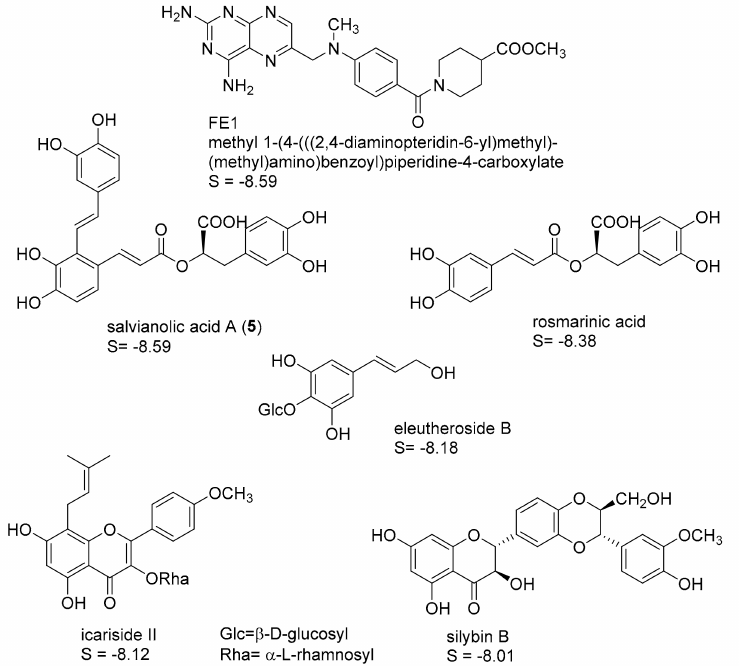
Figure 3. Best five hits from the virtual screening based on the FE1 pharmacophore ( Lm PTR1 PDB-ID “2QHX”); S-scores of the induced-fit docking simulations are given in kcal/mol. A “self-docking” computation of the co-crystallized inhibitor FE1 was performed